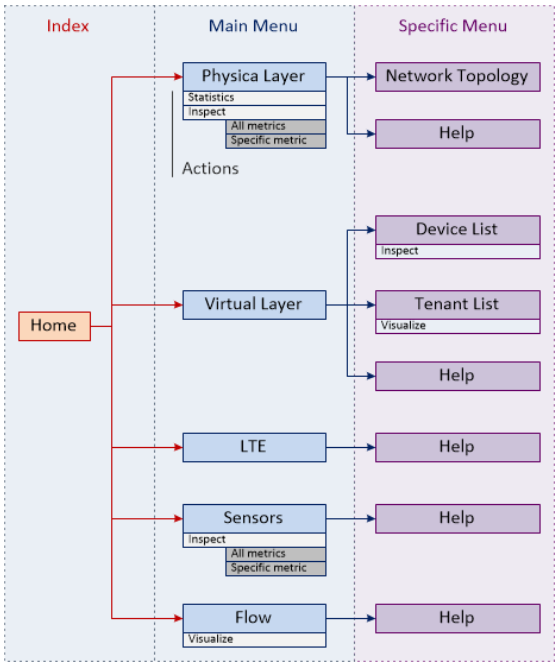
Figure 17. SELFNET Monitoring GUI navigability.